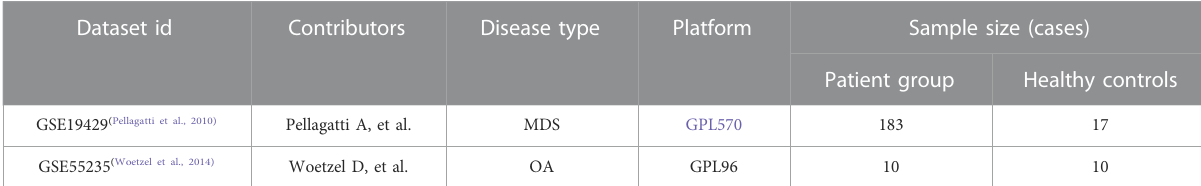
TABLE 1 Sequencing chip data